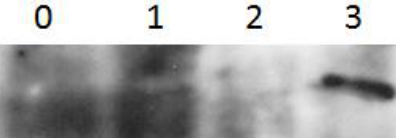
Figure 1. SELENBP1 protein expression analysis by western blot in the untreated HepG2 cells (1), in HepG2 cells after 24hrs of treatment with sodium selenite at the indicated doses, 0.25 mM (2) and 1mM (3), and in untreated HeLa cells